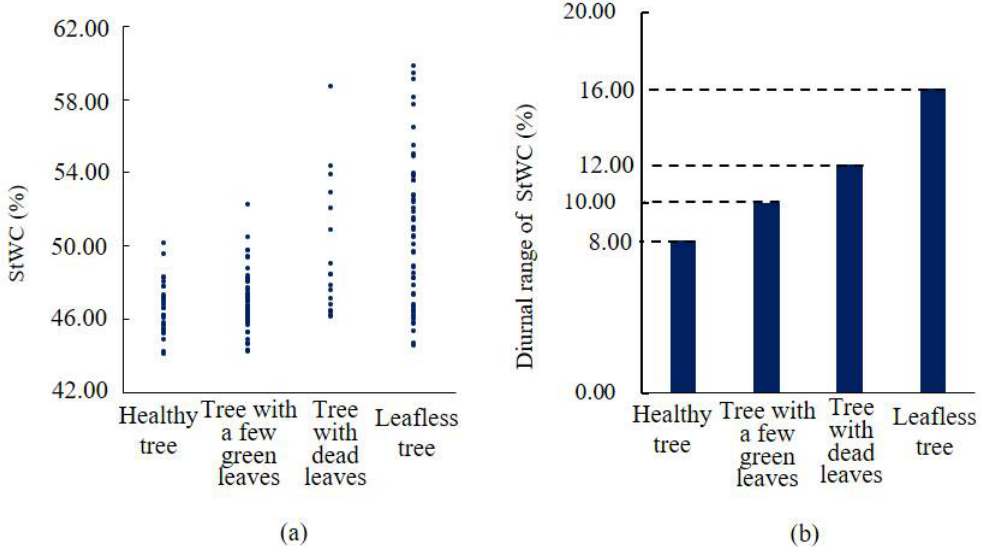
Figure 7. The second experimental group of Pinus sylvestris var. mongholica Litv . ( a ) StWC of trees in four different health conditions. ( b ) Diurnal range of StWC for trees in four different health conditions.